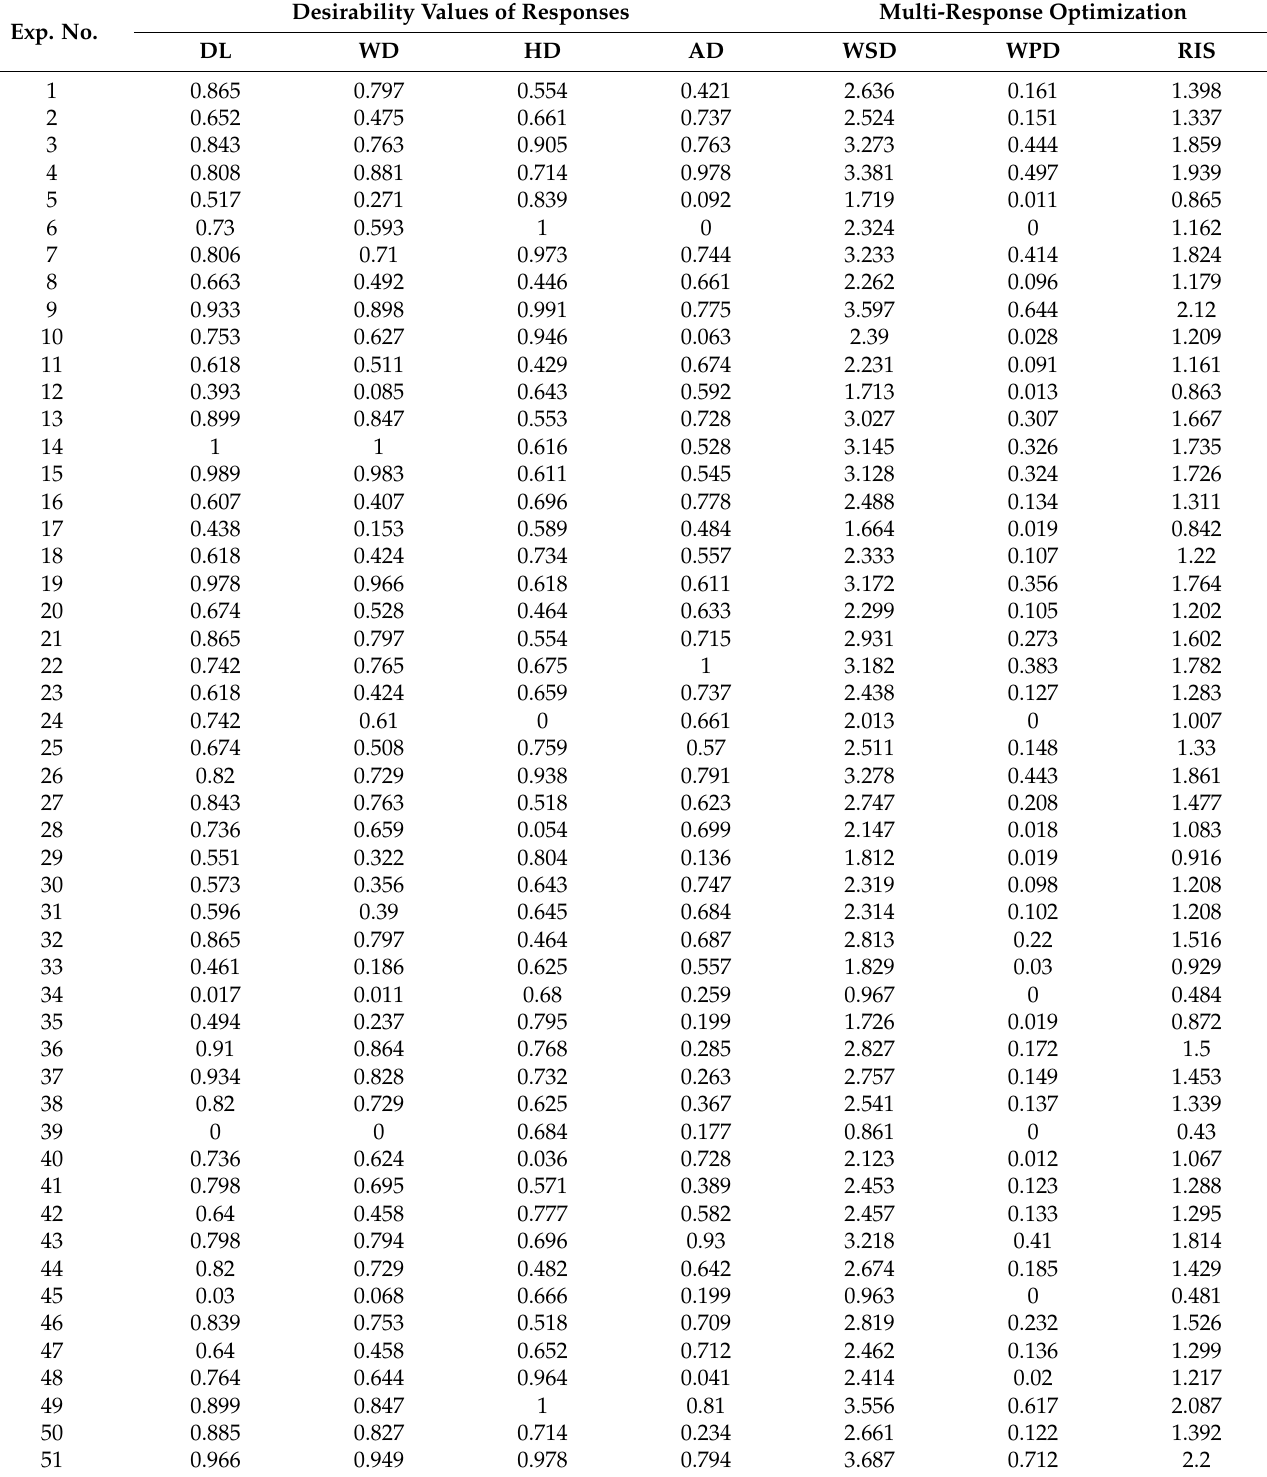
Table A2. Desirability and relative importance score values of